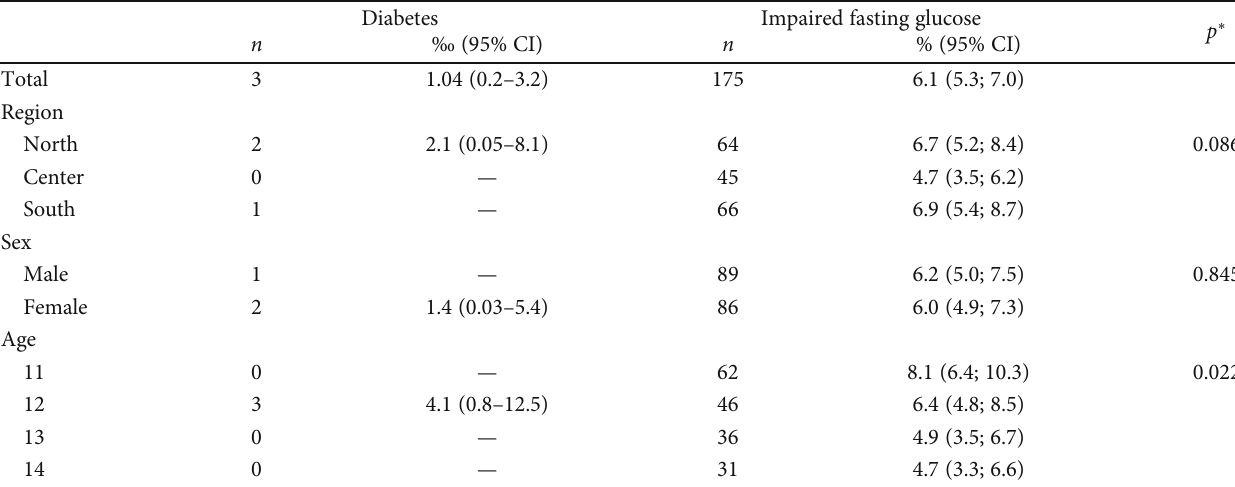
Table 2: Prevalence of children with diabetes and impaired fasting glucose.